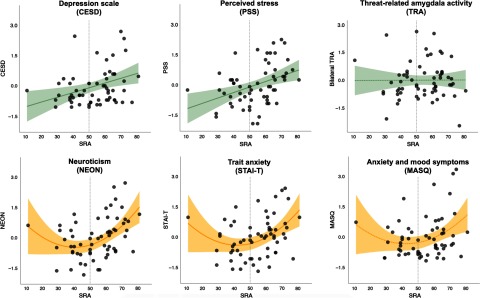
Amygdala self-rating and self-reported affective symptoms/distress. Depicted in green are models that showed a linear relationship between SRA and the outcome variable, which did not improve with addition of a quadratic term. Depicted in yellow are models that improved with addition of quadratic term. Dotted lines represent models that did not meet the significance threshold (p > .05). Shaded area represents a 95% confidence interval.